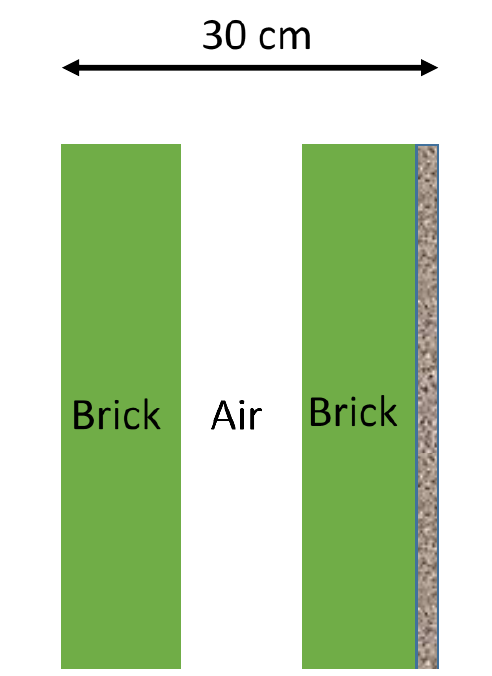
Figure 10. Building facade schematic.